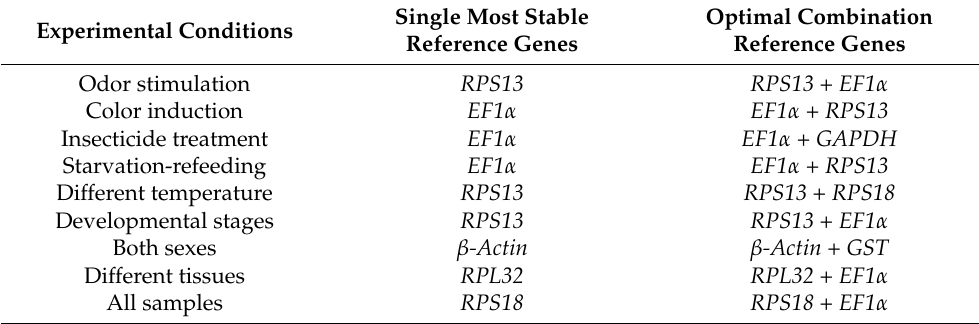
Figure 5. Stability of 15 candidate reference genes in N. asiatica under eight experimental conditions by RefFinder. In a RefFinder analysis, increasing Geomean values correspond to decreasing gene expression stability. The Geomean values for the following N. asiatica samples are presented: ( A ) Odor stimulation: samples treated with different odor compounds; ( B ) Color induction: samples treated with different colors; ( C ) insecticide treatment: samples treated with imidacloprid insecticide; ( D ) Starvation-refeeding: samples treated with chlorpyrifos; ( E ) Temperature: samples treated with different temperature; ( F ) Developmental stages: samples for all developmental stages; ( G ) Sex: samples for male adults and female adults; ( H ) Tissues: samples for different tissues; ( I ) All samples: all samples for all treatments. The details of 15 candidate RGs are listed in Table 1. The most stable genes are listed on the left, while the least stable genes are listed on the right. Table 4. Single most stable and optimal combination reference genes in N. asiatica under different experimental conditions.